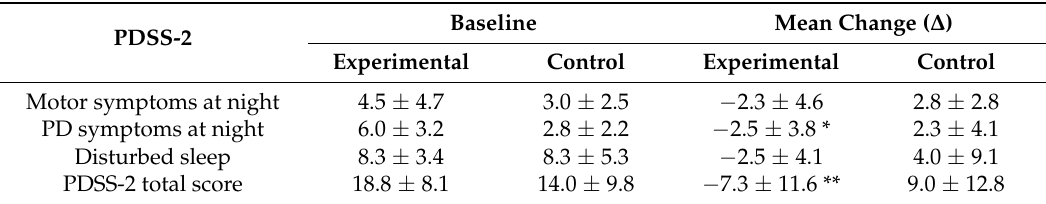
Table 4. Comparison of Parkinson’s Disease Sleep Scale 2 (PDSS-2) scores and mean changes ( ∆ ; ∆ = post-score – baseline-score) of the experimental and control groups.